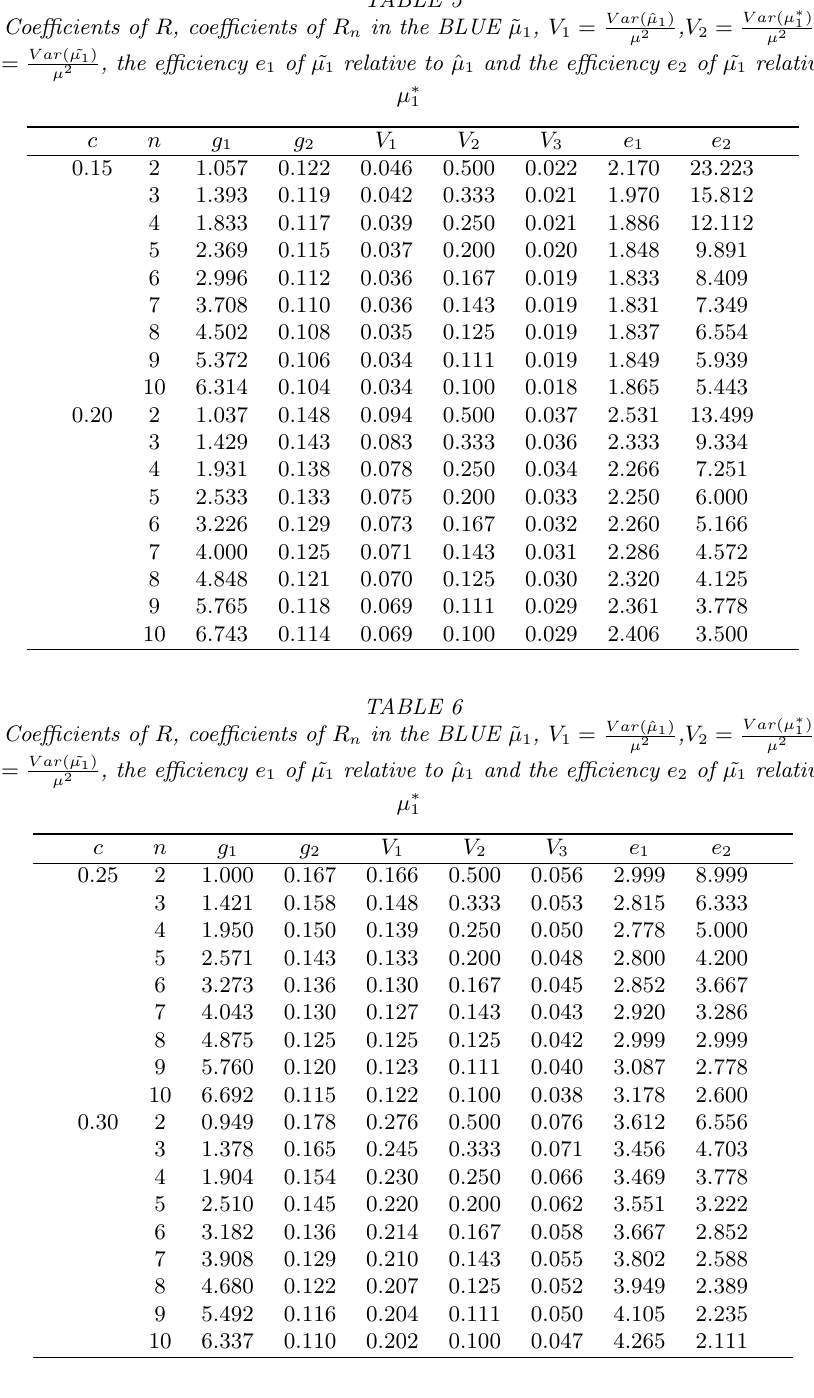
Coefficients of R , coefficients of R n in the BLUE ˜ (cid:22) 1 , V 1 = V ar (^ (cid:22) 1 )